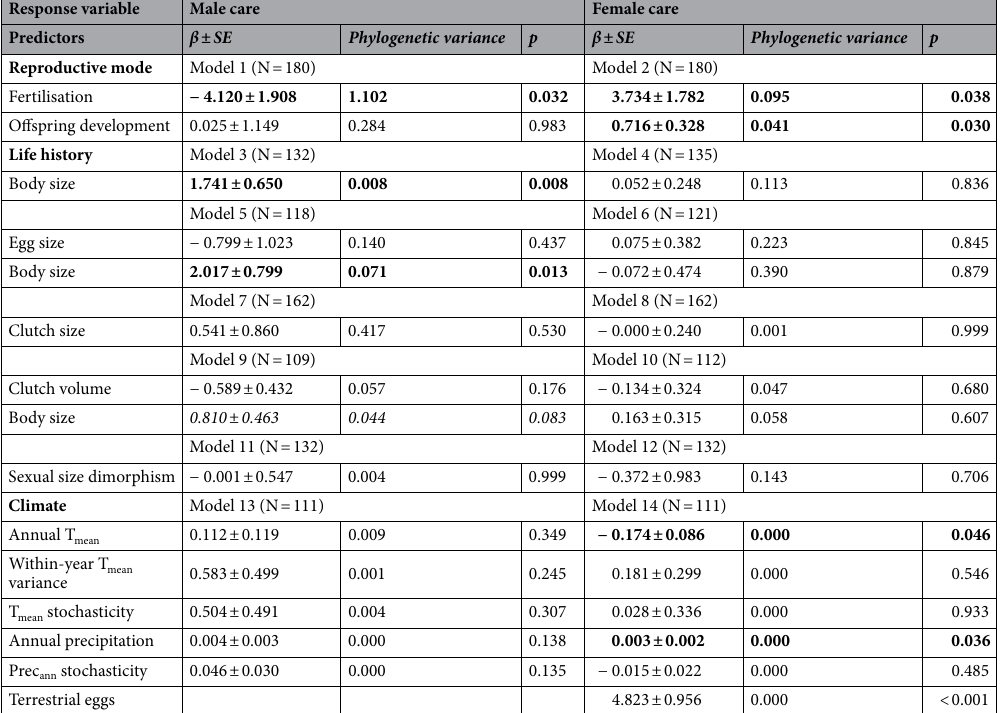
Table 1. Predictors of female and male care in salamanders. Phylogenetic generalized linear models (phyloGLM) of female-only or male-only care (response variables) in relation to reproductive modes